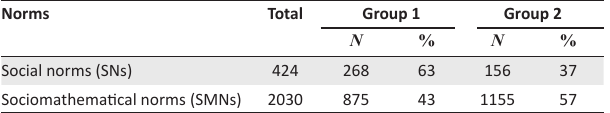
TABLE 3: Total number of social norms and sociomathematical norms for groups 1 and 2. Norms